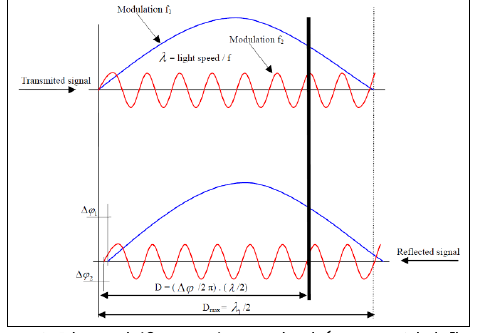
Figure 4. Phase shift scanning method (source: Abdelhafiz, 2000)